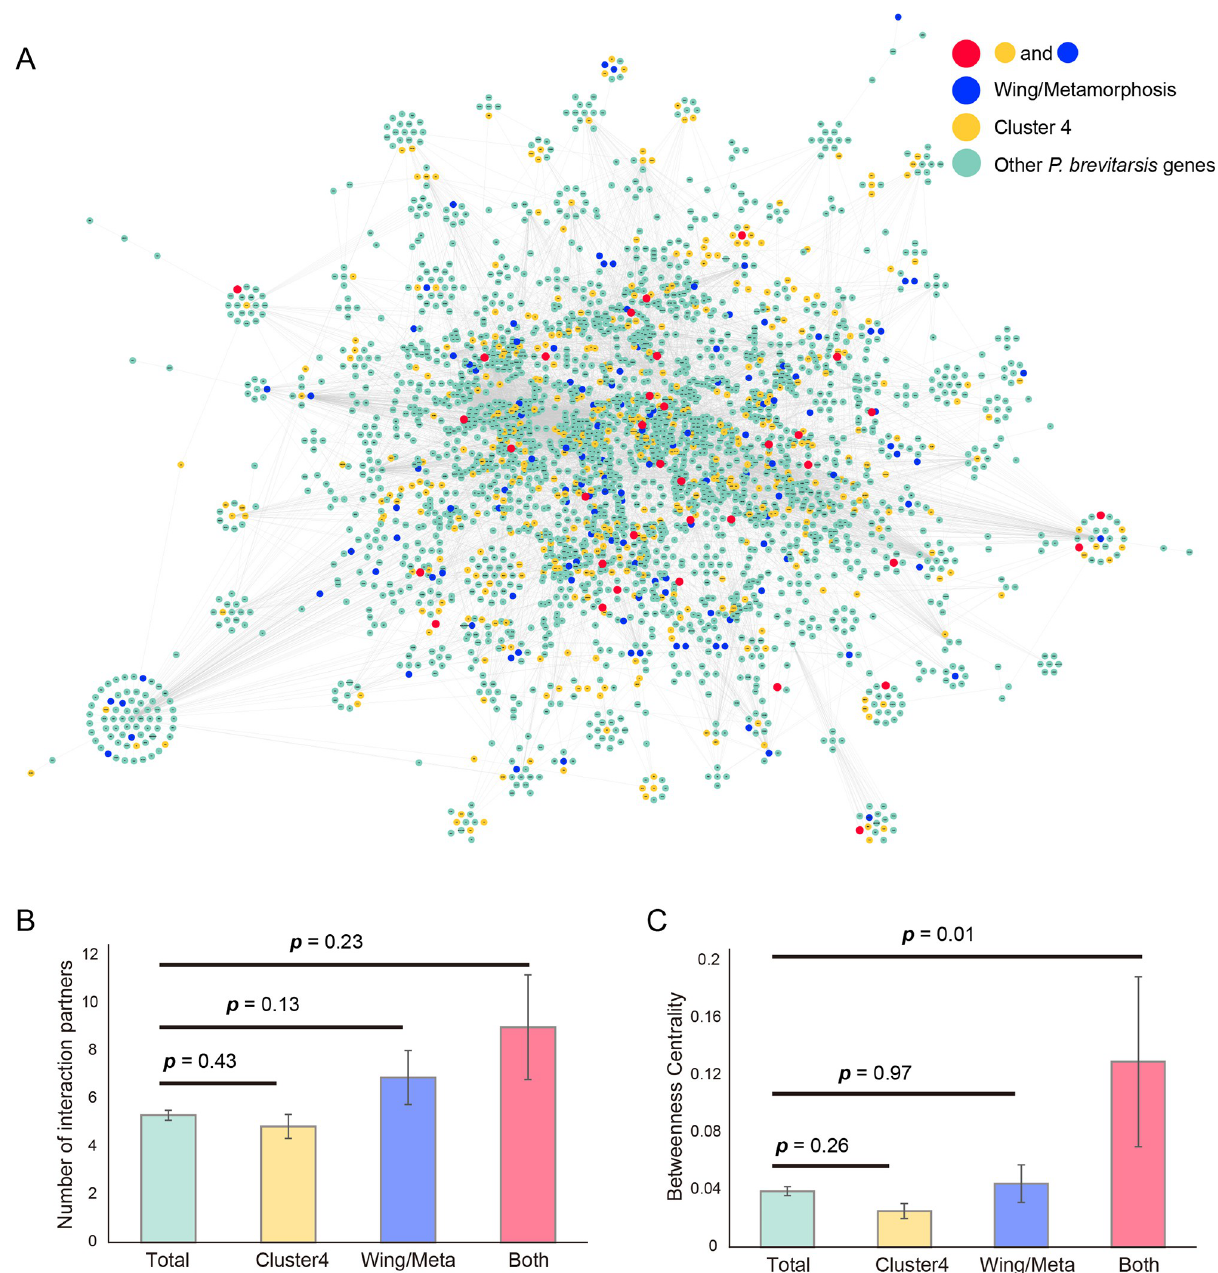
Fig 5. P. b. seulensis network. Functional association network analysis. ( a ) Functional association network in P. b. seulensis . Nodes in the same group are coded with the same color. Cyan, yellow, blue, and red nodes represent P. b. seulensis , cluster 4, wing development and metamorphosis-related, and both cluster 4 and wing development and metamorphosis-related genes, respectively. ( a, c ) The average number of interacting partners and betweenness centrality score of the P. b. seulensis , cluster 4, wing development and metamorphosis-related, and both cluster 4 and wing development and metamorphosis-related genes. Statistical analysis was performed using the Mann-Whitney U